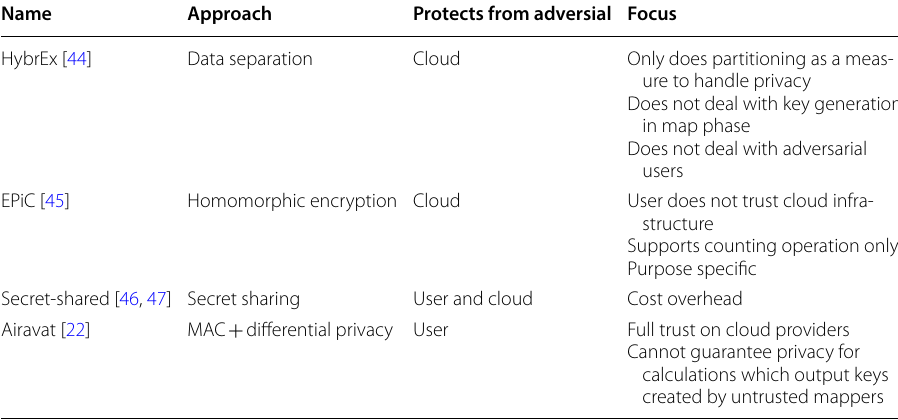
Table 1 Privacy mechanisms in big